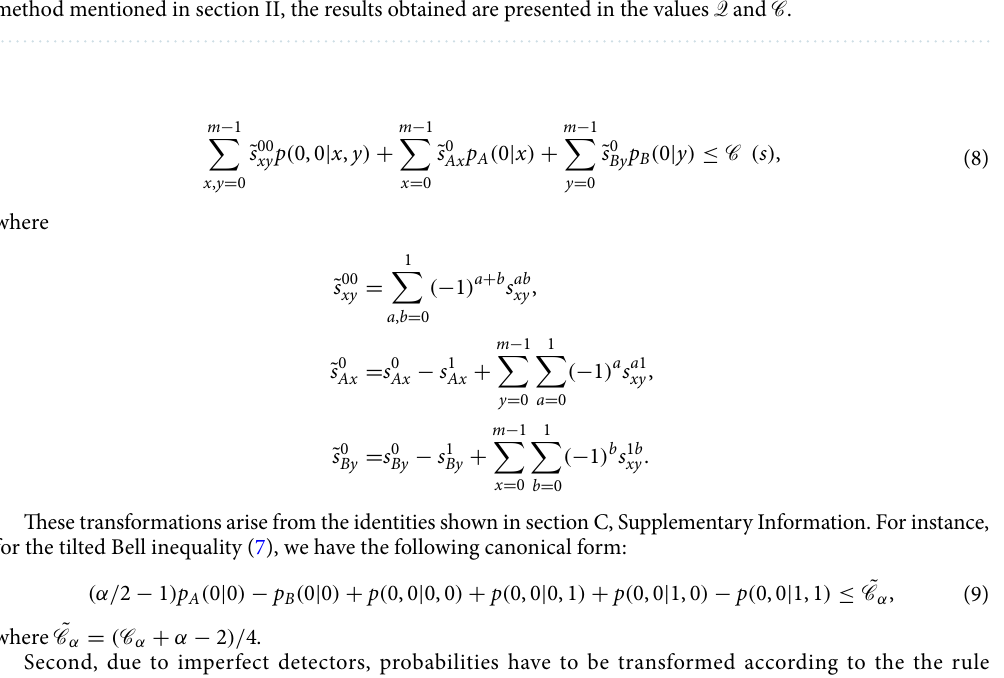
Table 1. Summary of results. The concurrence was obtained from quantum state tomography. Q α refers to the experimental values of the Tilted Bell inequality. C α is the LHV bound for each α . After implementing the method mentioned in section II, the results obtained are presented in the values Q and C